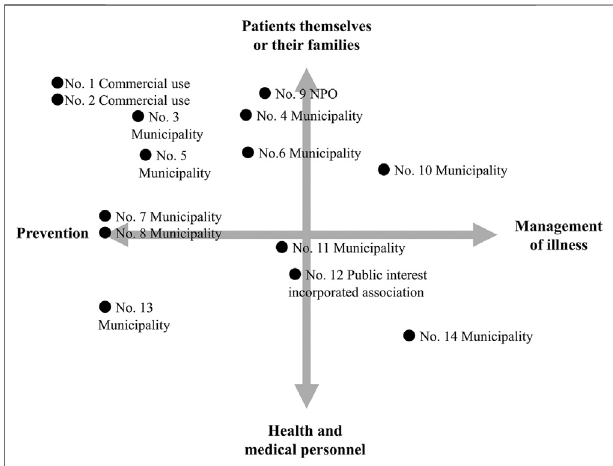
FIGURE 1 | Classi fi cation of characteristics of health handbooks based on the purpose-user matrix.